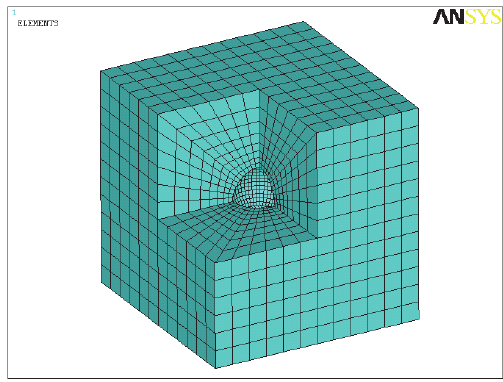
Figure 1: Elementary cell FE